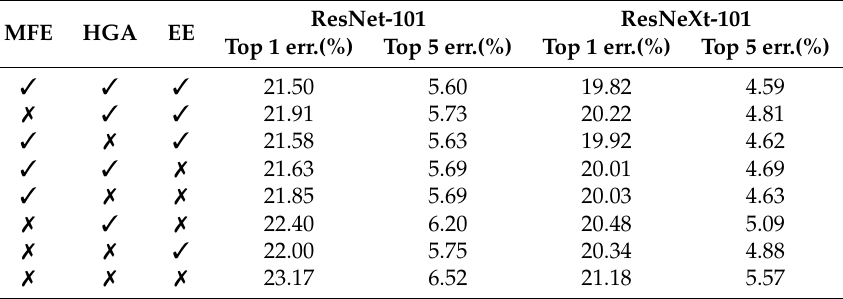
Table 5. Comparisons of different module